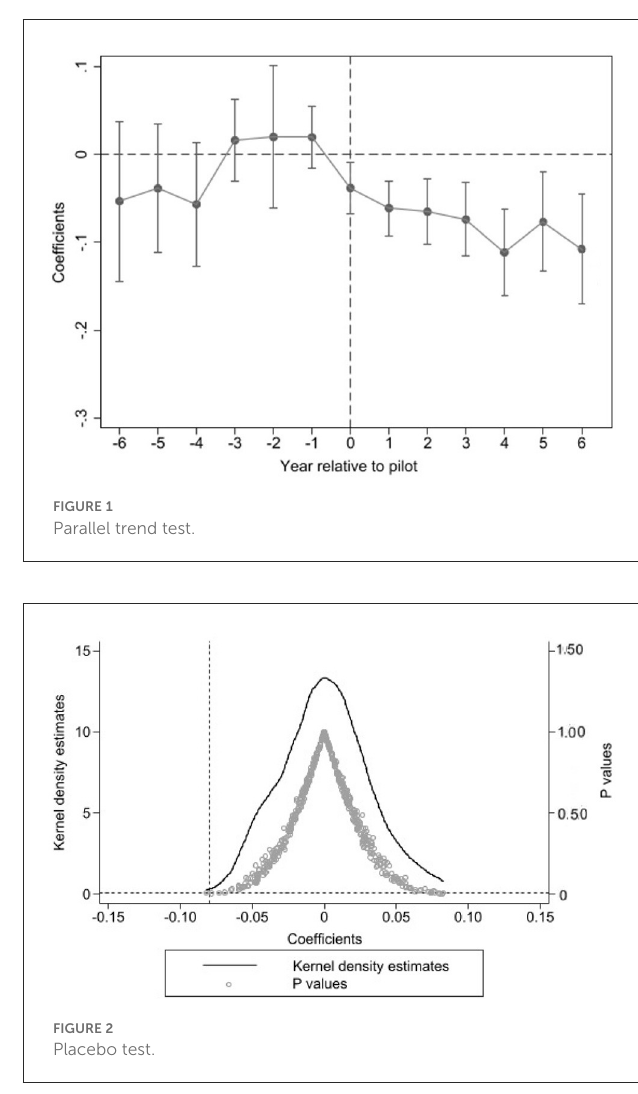
FIGURE2 Placebo test.